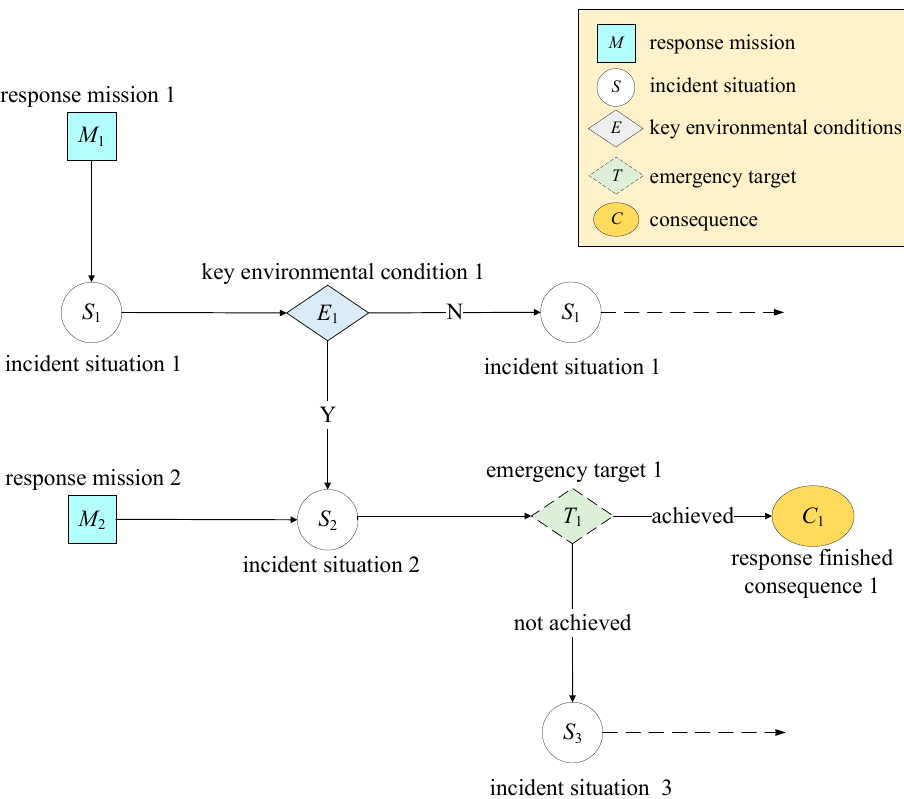
Figure 2. A portion of an incident evolution diagram.